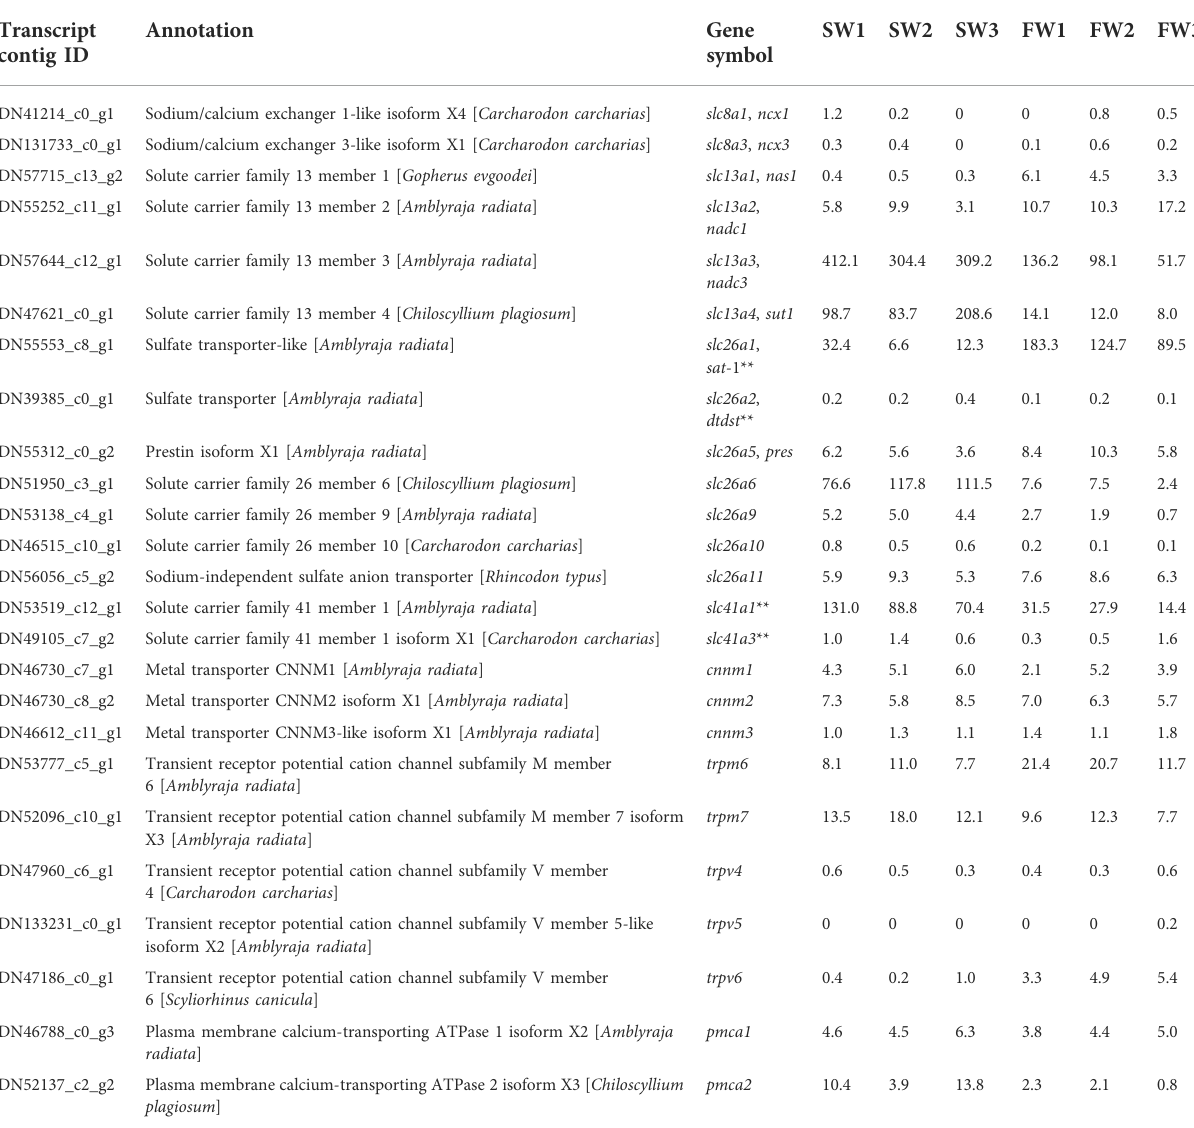
TABLE 5 Expression of genes putatively linked to divalent ion reabsorption in the transcriptomic analysis. Transcript Annotation Gene contig ID